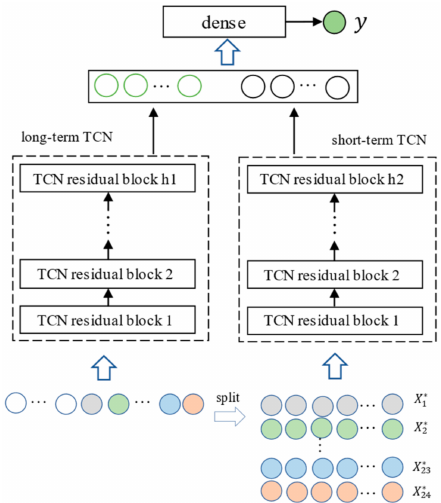
Figure 5. LST-TCN overall structure.